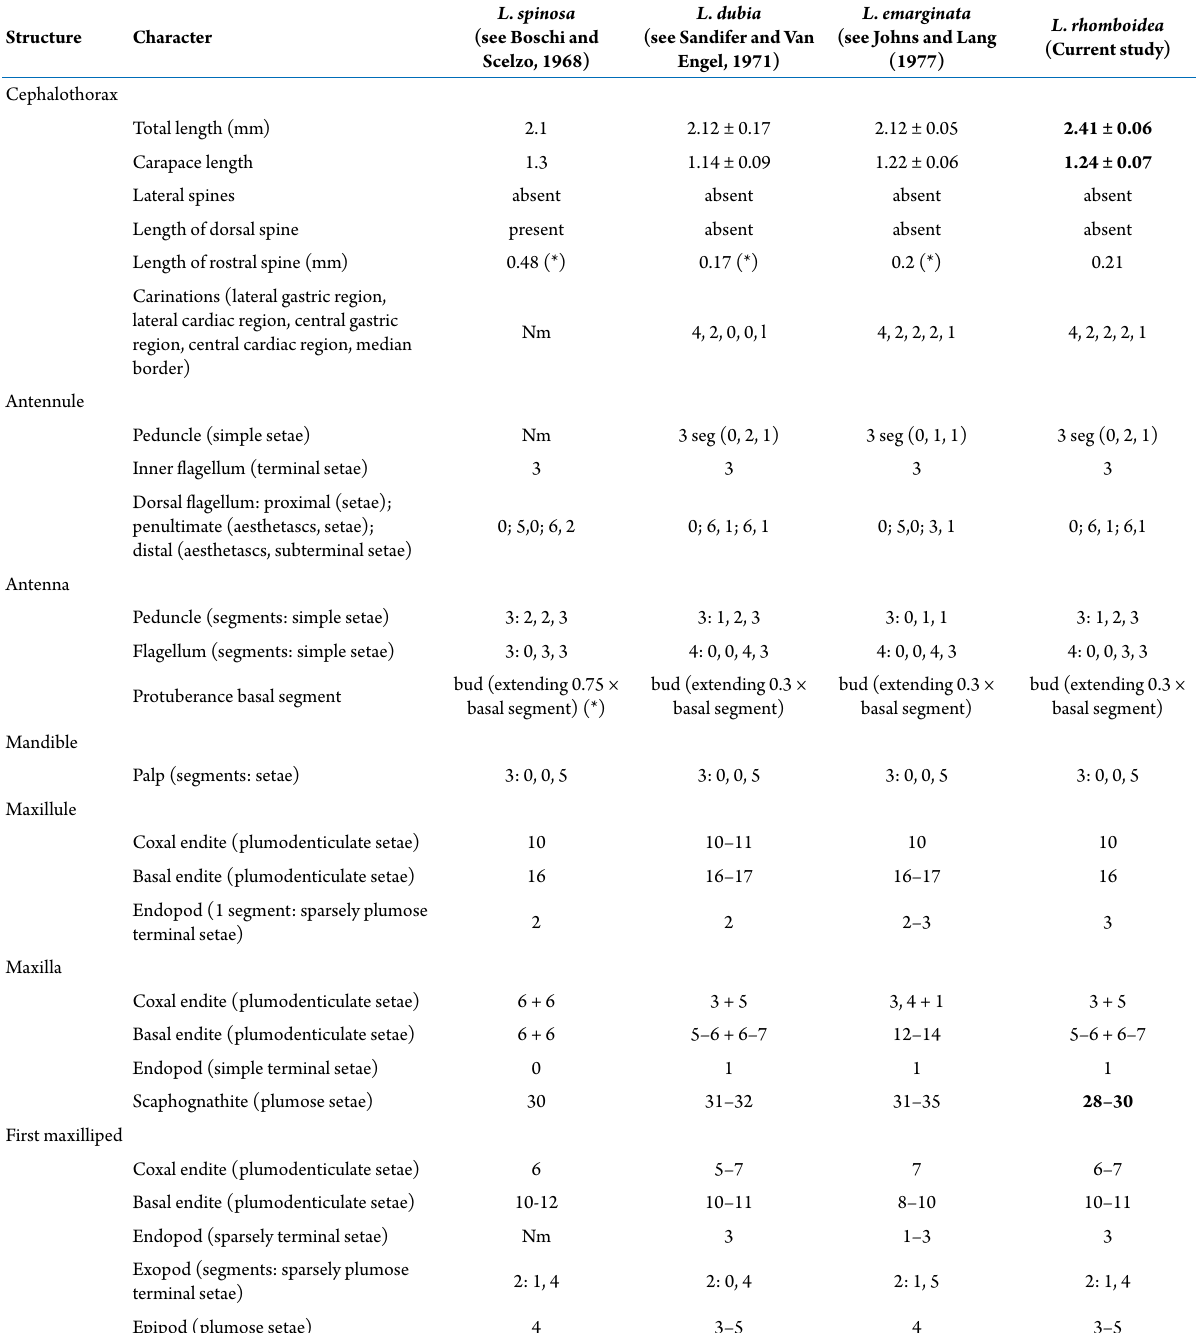
Table 3. Megalopa of Libinia spp. Character comparison of four species. ND, not described; Nm, not mentioned; (*) obtained from the figure. Bold type indicates observed